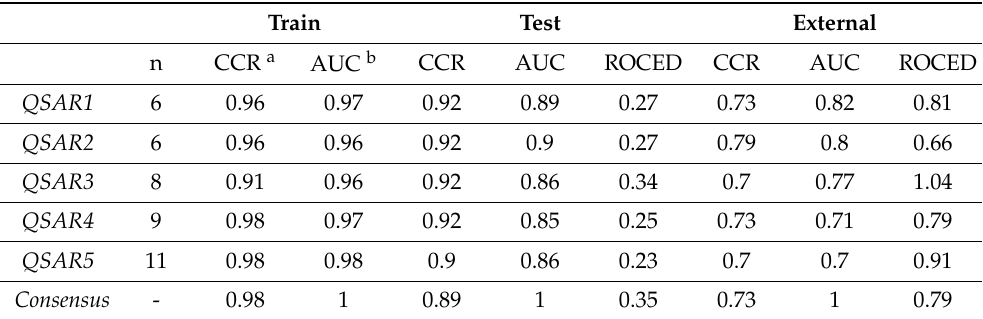
Table 1. Best QSAR models selected and consensus model with its statistical parameters (only values of CCR, AUC, and ROCED are shown).